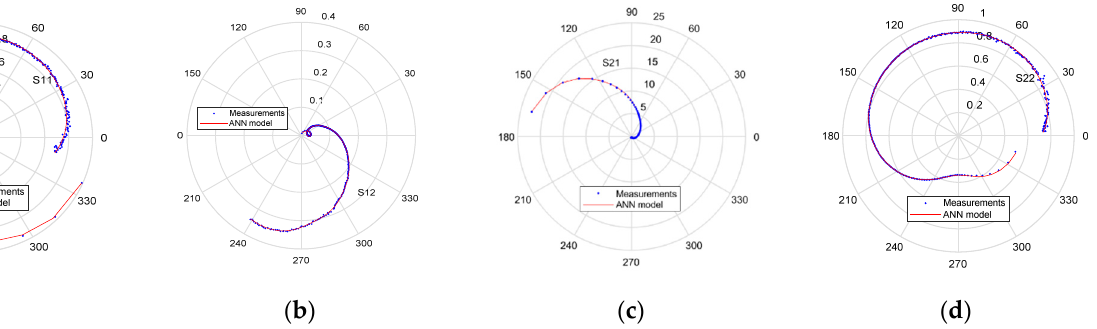
Figure 10. Measured (blue symbols) and ANN simulated (red lines) behavior of ( a ) S 11 , ( b ) S 12 , ( c ) S 21 , and ( d ) S 22 with the frequency range spanning from 200 MHz to 65 GHz for the DUT at V DS = 30 V, V GS = − 3.1 V, and T a = 35 °C.